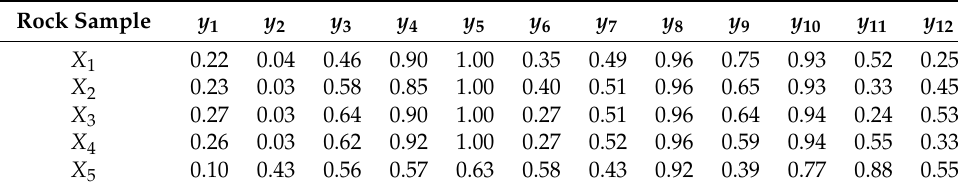
Table 3. Normalized values of the evaluation indexes for the slope rock mass stability. Rock Sample